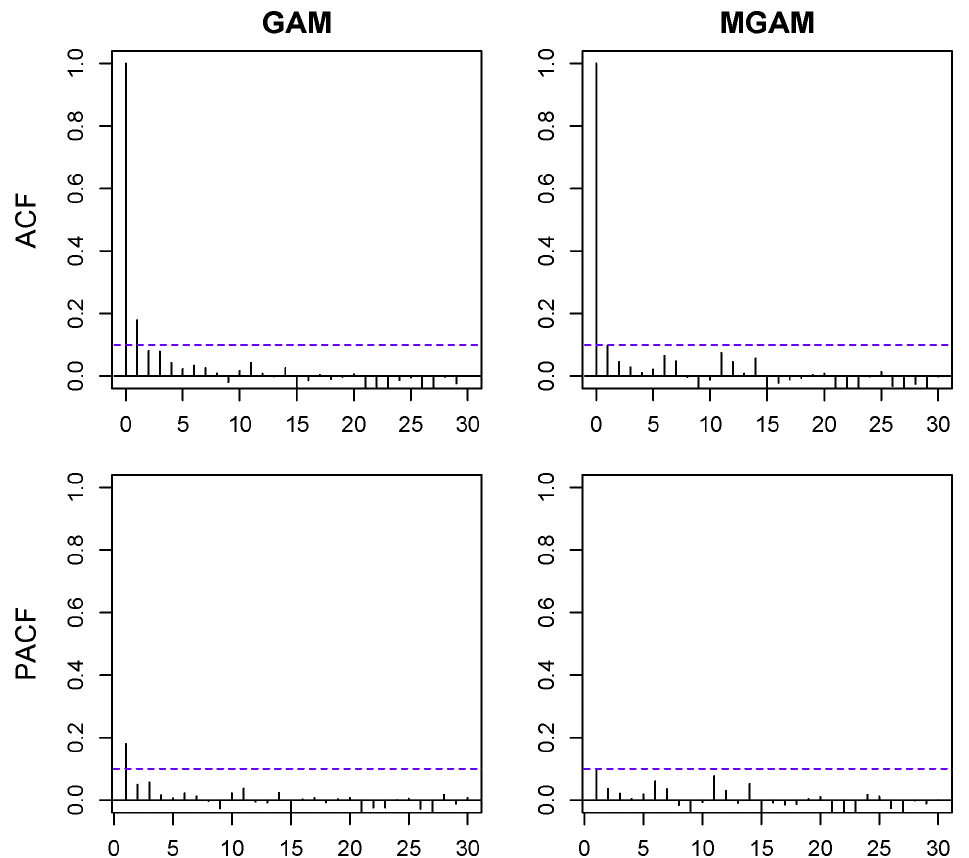
Figure 6. Residual autocorrelation and partial autocorrelation of GAM and MGAM with df t =20. Upper left is the autocorrelation function (ACF) of GAM residuals. Upper right is the ACF of MGAM residuals. Lower left is the partial autocorrelation function (PACF) of GAM residuals. Lower right is the PACF of MGAM residuals.